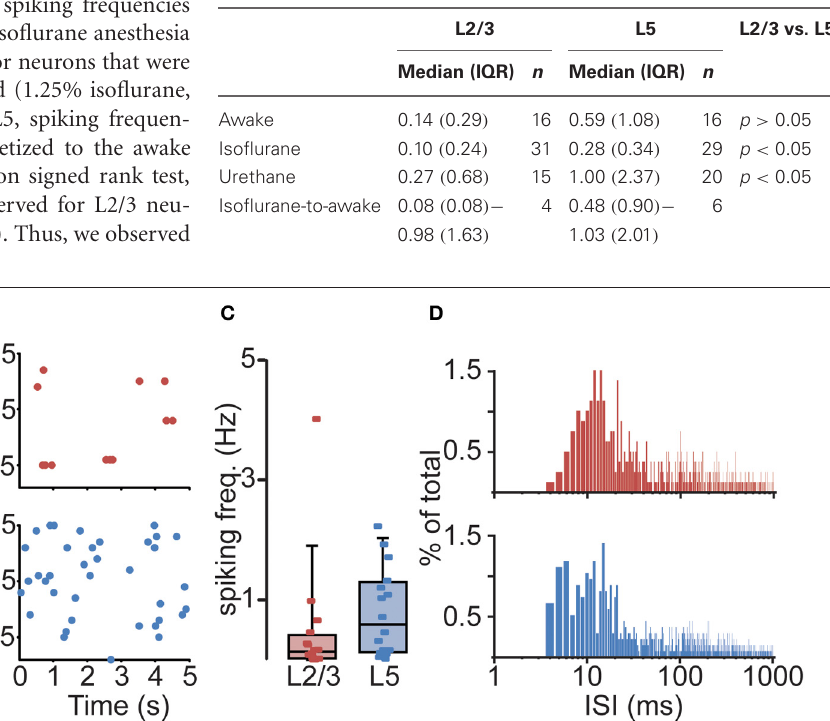
cell-type-specific median spiking frequencies for L2/3 ( n = 16) and L5 ( n = 16) neurons in awake animals. No difference could be observed in spiking activity between L2/3 and L5 neurons. (D) Histogram illustrating the distribution of interspike intervals (ISIs) for L2/3 (upper panel) and L5 (lower panel). Note the positive skew in the distribution, indicating that APs are often found in close temporal